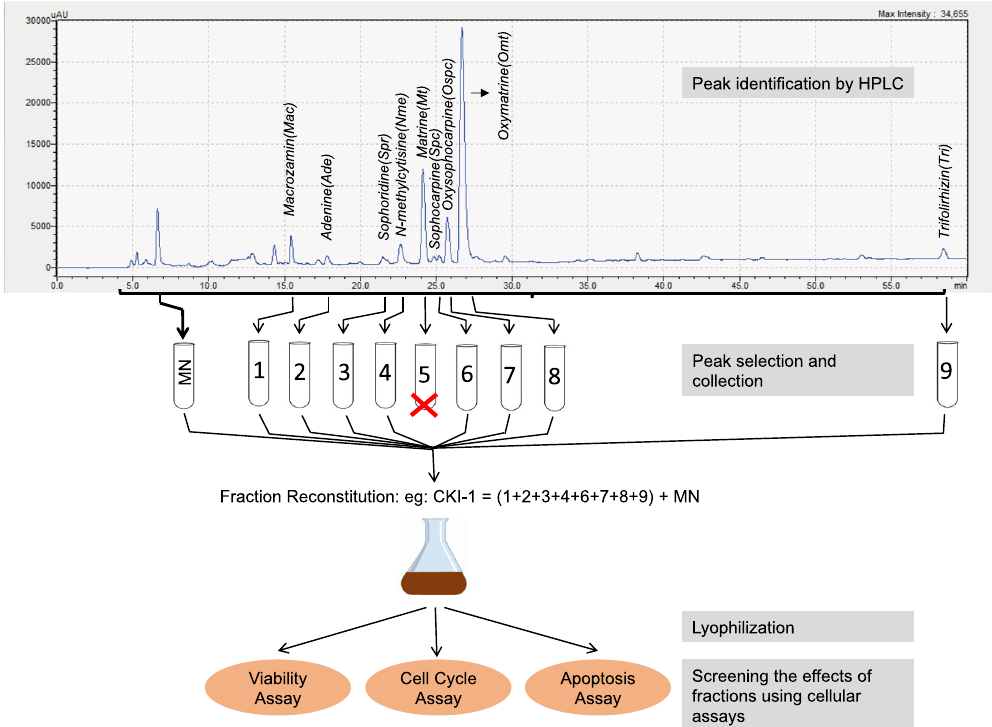
Figure 1. Fractionation of CKI. Diagram illustrating the process of subtractive fractionation, reconstitution, and screening of fractionated compounds using three cell-based